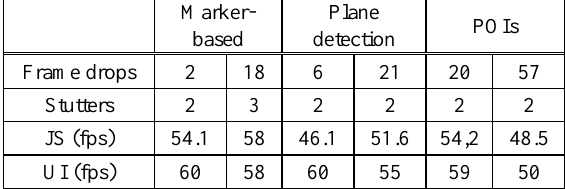
Table 2. Low-level performance metrics recorded by the built- in performance monitor: the first column corresponds to the metrics on scenario initialization and the second one to the same metrics after 3D models‘ drawn time